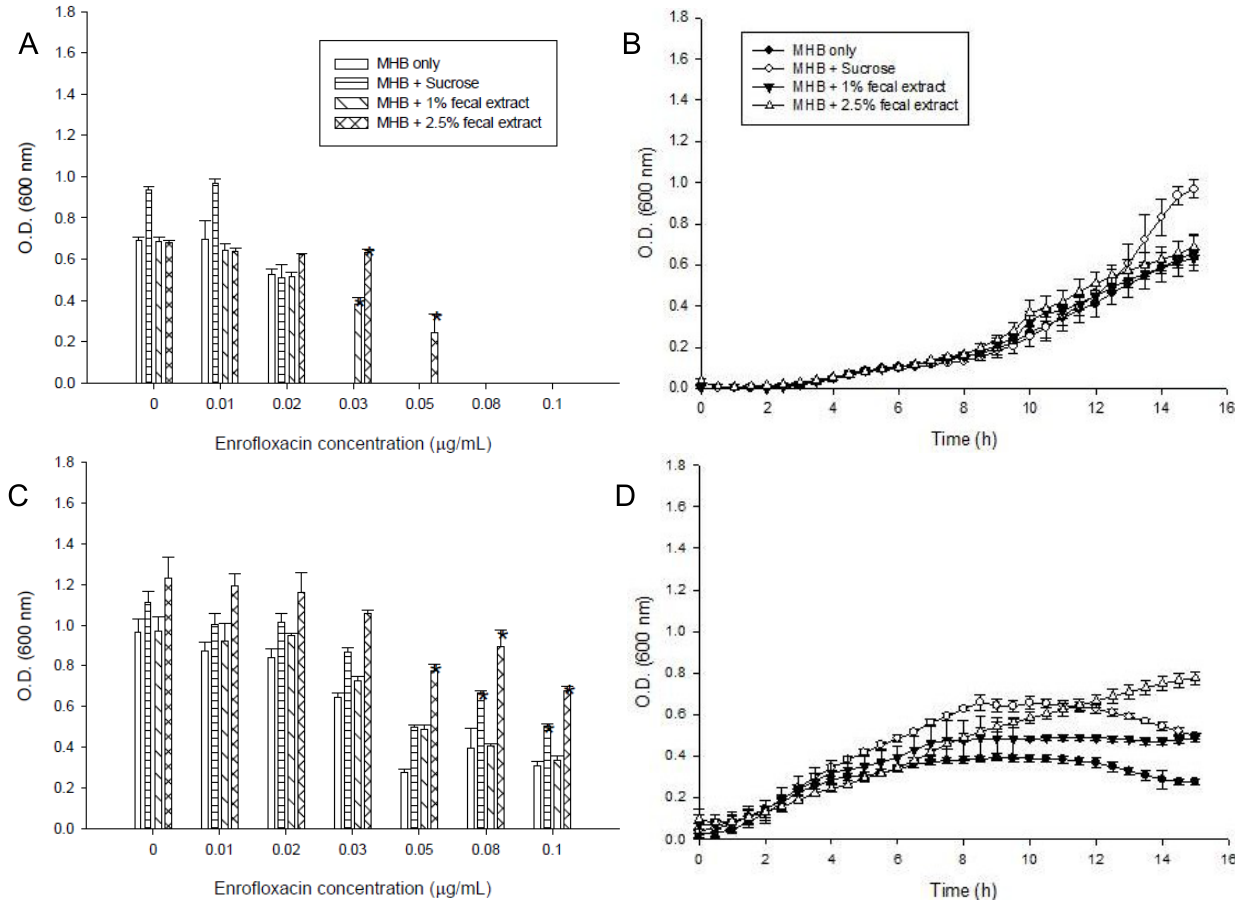
Figure 2. Effects of different concentrations of enrofloxacin on growth of Listeria monocytogenes ATCC 15313 in media containing 5 mM sucrose, or 1% or 2.5% sterilized extract from a human fecal sample, ( A ) in the first passage; ( B ) Kinetics of growth of L. monocytogenes in media with different supplements in 0.01  g/mL enrofloxacin; ( C ) Maximum cell growth measured in the third passage in media with different supplements; ( D ) Kinetics of growth of L. monocytogenes in 0.05  g/mL of enrofloxacin measured in the third passage. Symbols represent averages of triplicates from three samples and error bars represent the standard deviations. * Indicates statistically significant differences from control ( p <